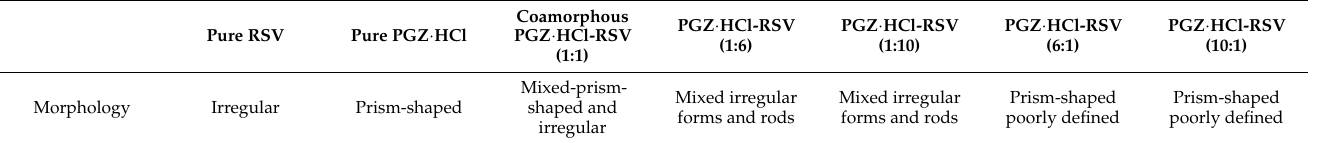
Morphology Irregular Prism-shaped